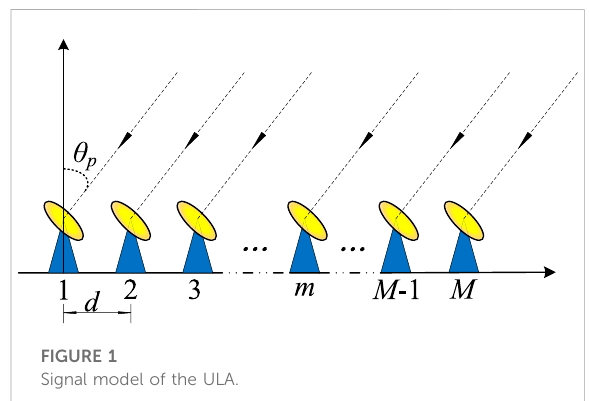
FIGURE 1 Signal model of the